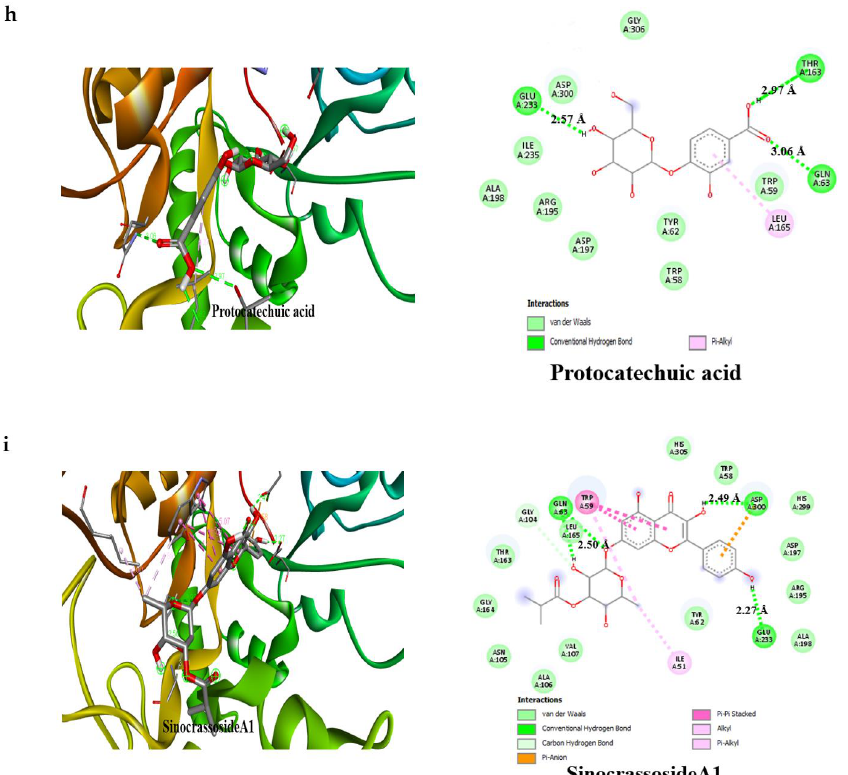
Figure 5. Model of the interaction and the 2D Structure of α-amylase protein with ( a ) 3-caffeoylquinic acid, ( b ) 3- O - Caffeoyl-4- O -methylquinic acid, ( c ) 4-Feruloylquinic acid, ( d ) 5-Feruloylquinic acid, ( e ) Arbutin, ( f ) Engeletin, ( g ) Acar- bose, ( h ) Protocatechuic acid, and ( i ) SinocrassosideA1.